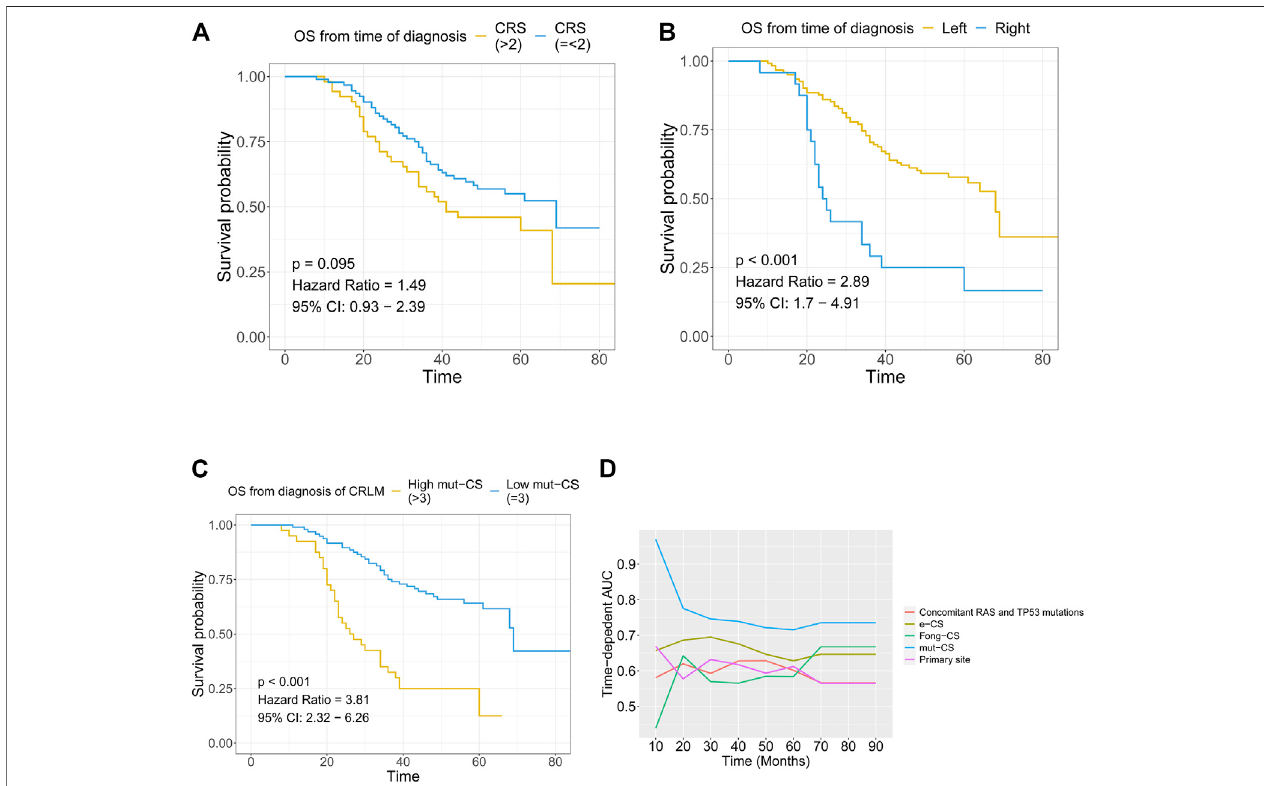
FIGURE 5 | Combination of the mutation-based gene signature and clinical variables to establish the mut-CS scoring system to improve risk assessment and strati fi cation (A) TheassociationbetweenFong-CRSandOSfromthetimeofdiagnosisofCRLM (B) TheassociationbetweentheprimarysiteofCRLMandOSfromthe time of diagnosis of CRLM (C) The association between mut-CS and OS from the time of diagnosis of CRLM (D) Time-dependent ROC analysis was performed to evaluate the predictive power of the mut-CS scoring system for OS in CRLM patients. OS: overall survival, CRLM: colorectal liver metastases.